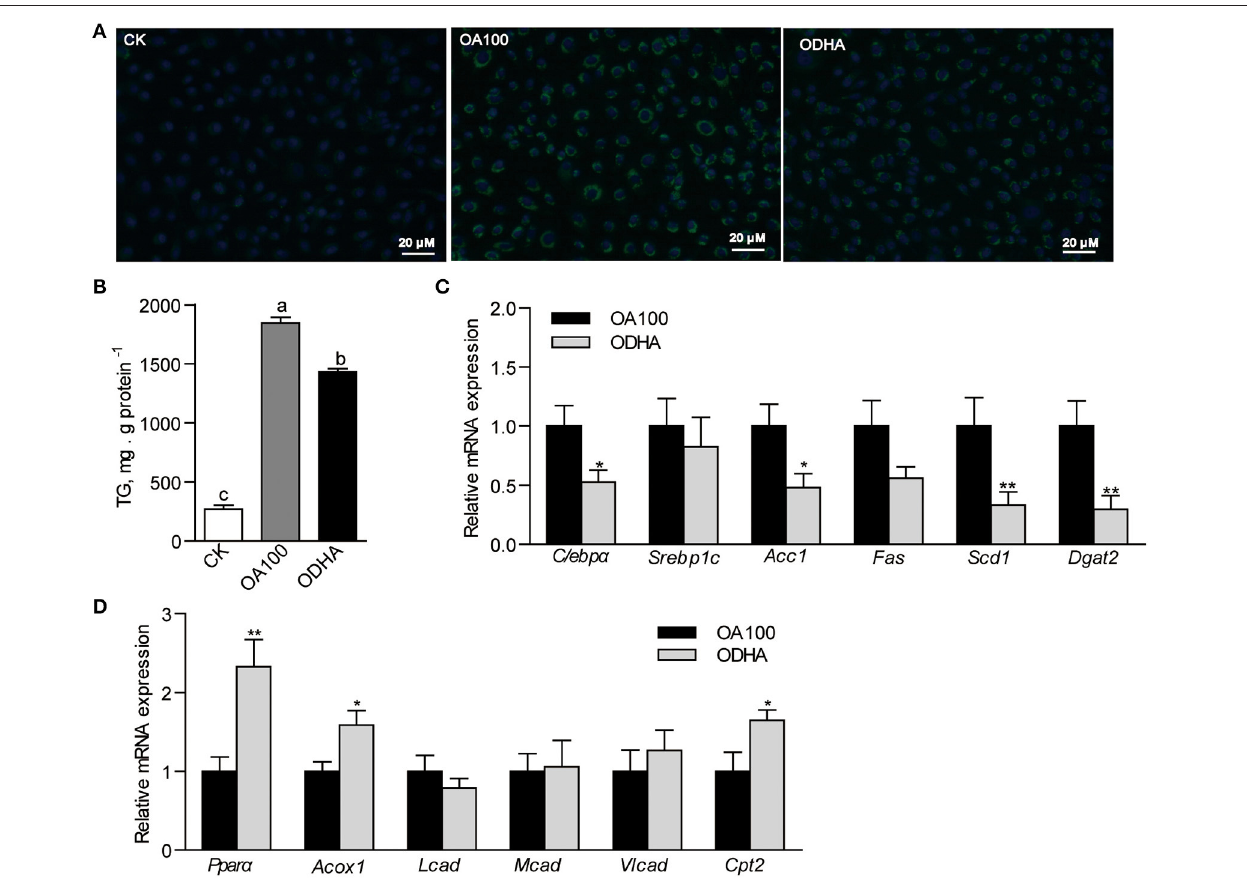
FIGURE 3 | Modulation of DHA on lipid metabolism in ZFL cells. (A) Lipid droplets accumulation in ZFL cells with lipid treatment. The scale bar is 20 µ m. (B) TG content in ZFL cells treated with CK, OA, and ODHA. (C) Relative mRNA expression of genes related to lipid synthesis and (D) β -oxidation in control and lipid treated ZFL cells. Values are means ± SEMs ( n = 5-6 biological replicates). Means without a common letter are significantly different, P < 0.05. * P < 0.05; ** P < 0.01. CK, controls; OA, 100 µ M oleic acid; ODHA, mix of 50 µ M OA and 50 µ M